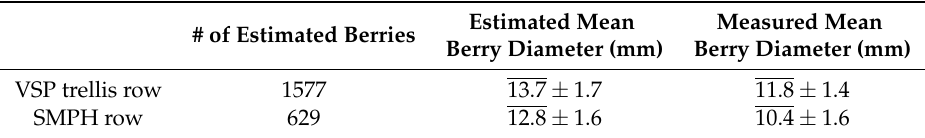
Table 8. Final number of berries and berry diameter estimation for 5 m of both rows. # of Estimated